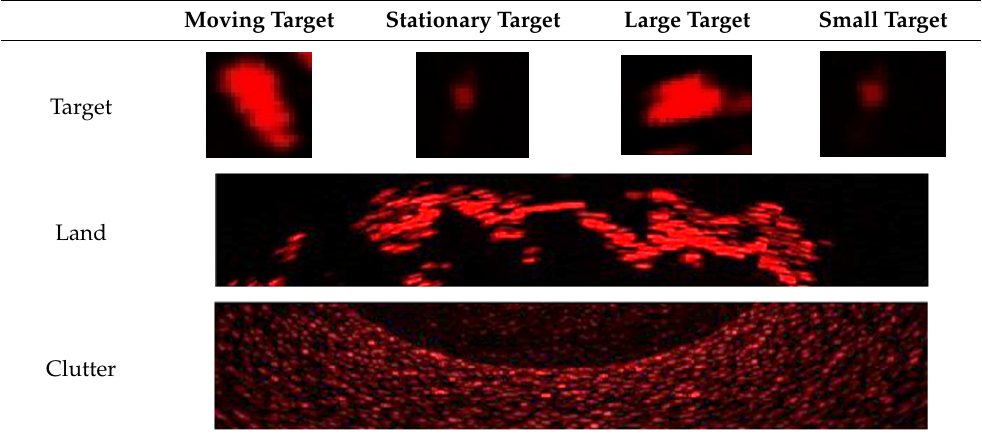
Table 2. Radar PPI image dataset annotation.